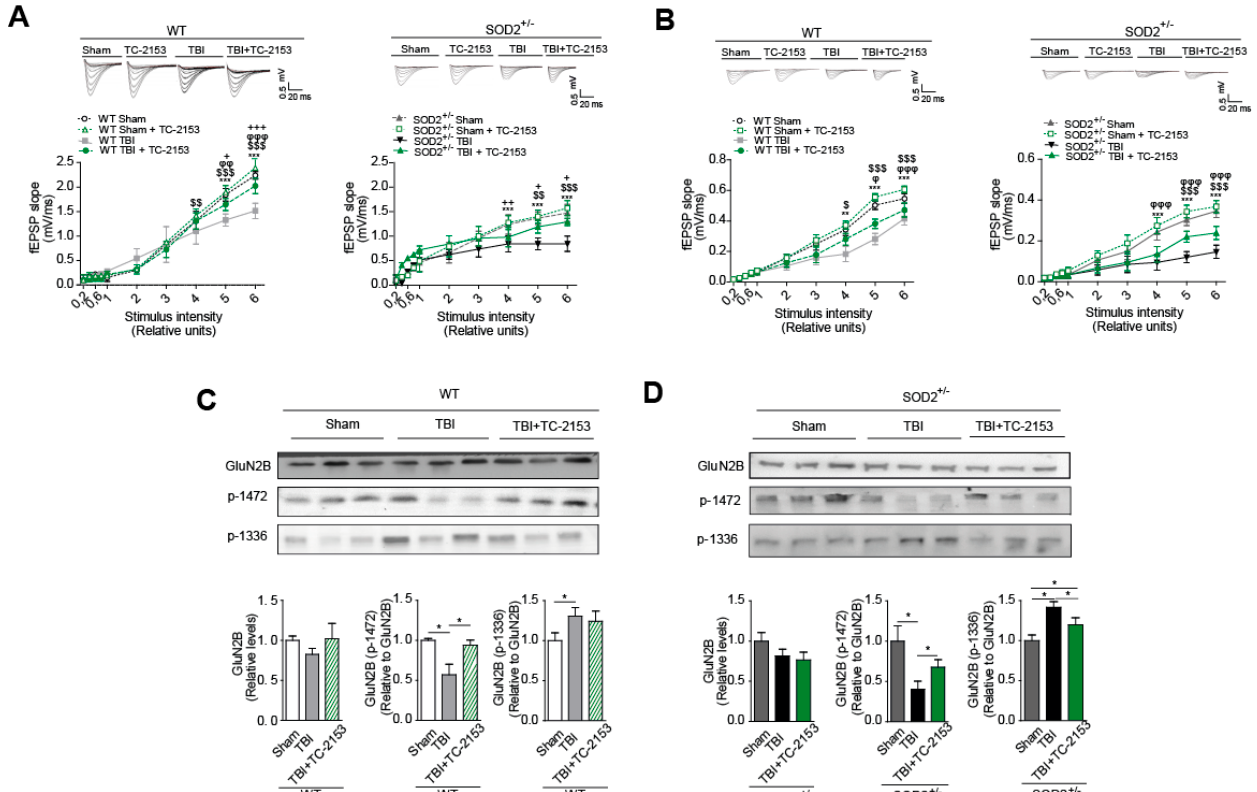
Figure 8. Pharmacological inhibition of STEP 61 restores the NMDA synaptic response and NMDA subunit phosphorylated status after TBI. fEPSP slope induced by the input-output protocol to record total responses ( A ) and responses corresponding to NMDARs ( B ) from WT and SOD2 +/ − mice after TBI. C. Immunoblot analyses of phosphorylated GluN2B subunits of